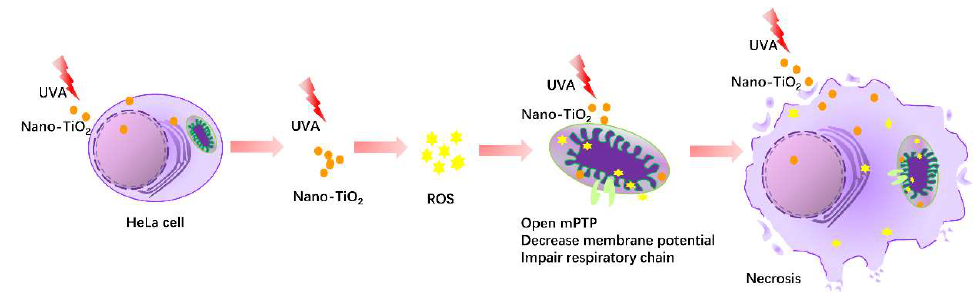
Figure 7. The potential mechanism of HeLa cell necrosis by nano-TiO 2 and UVA irradiation.